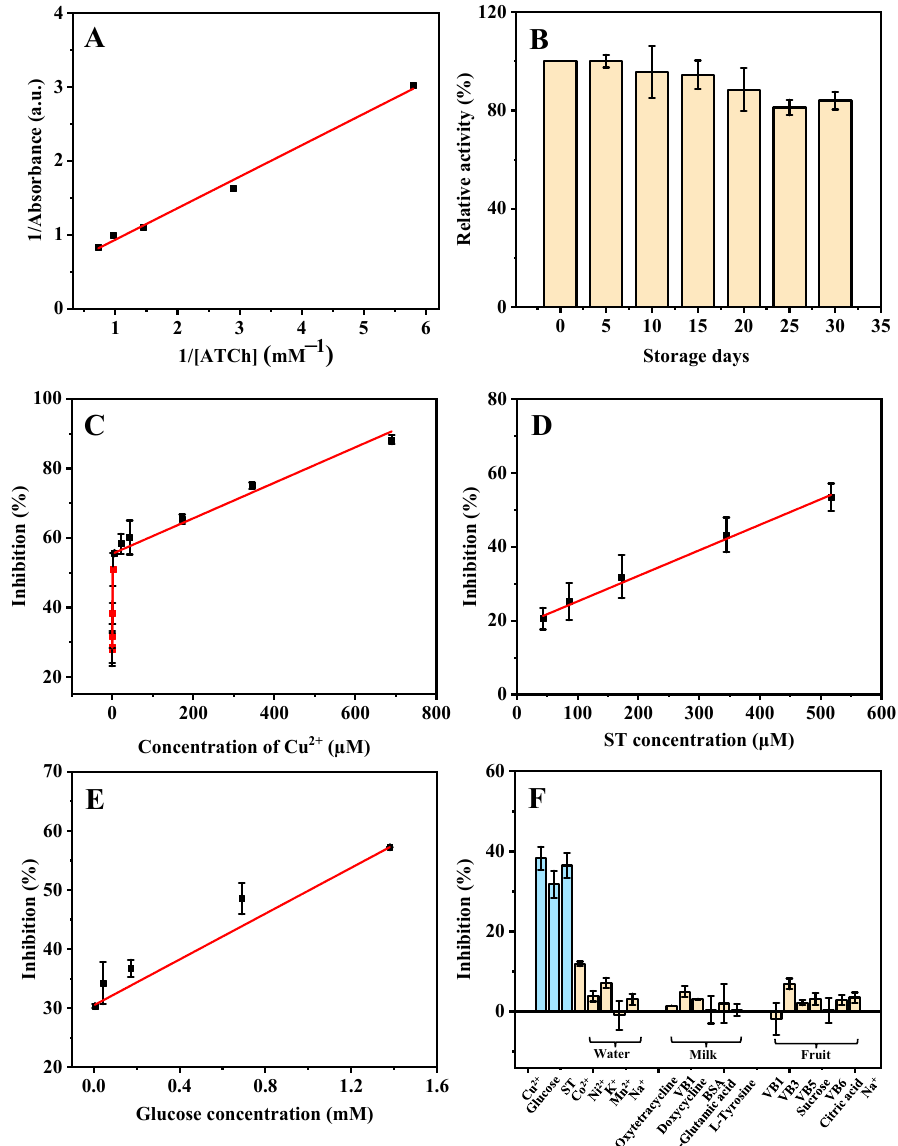
Figure 4. Double reciprocal plot ( A ) and storage stability ( B ) of the ZIF-8 catalyzed activity. The linear range of Cu 2+ ( C ), ST ( D ), and glucose ( E ), and the selectivity ( F ) for the detection of Cu 2+ , ST, and glucose based on the AChE-like activity of ZIF-8 under the optimized conditions. ATCh concentrations are from 0.17 to 1.40 mM for ( A ). Cu 2+ concentrations are from 0.021 to 689.66 µ M for ( C ). ST concentrations are from 43.10 to 517.24 µ M for ( D ). Glucose concentrations are from 0.0054 to 1.40 mM for ( E ). Cu 2+ , ST, and glucose concentrations are 0.67 µ M, 172.41 µ M, and 0.043 mM, respectively; other possible ions in lake water (Co 2+ , Ni 2+ , K + , Mn 2+ , Na + ) are 344.82 µ M; other possible substances in milk (oxytetracycline, doxycycline, VB1, L-glutamic acid, BSA, and L-tyrosine) are 172.41 µ M; other possible substances in strawberry (VB1, VB3, VB5, VB6, sucrose, citric acid, and Na + ) are 344.83 µ M for ( F ). Other conditions: buffer pH, 8; the volume of ZIF-8, 80 µ L; reaction temperature, 50 ◦ C; reaction time, 10 min; ATCh concentration, 5.17 mM; DTNB concentration, 1.38